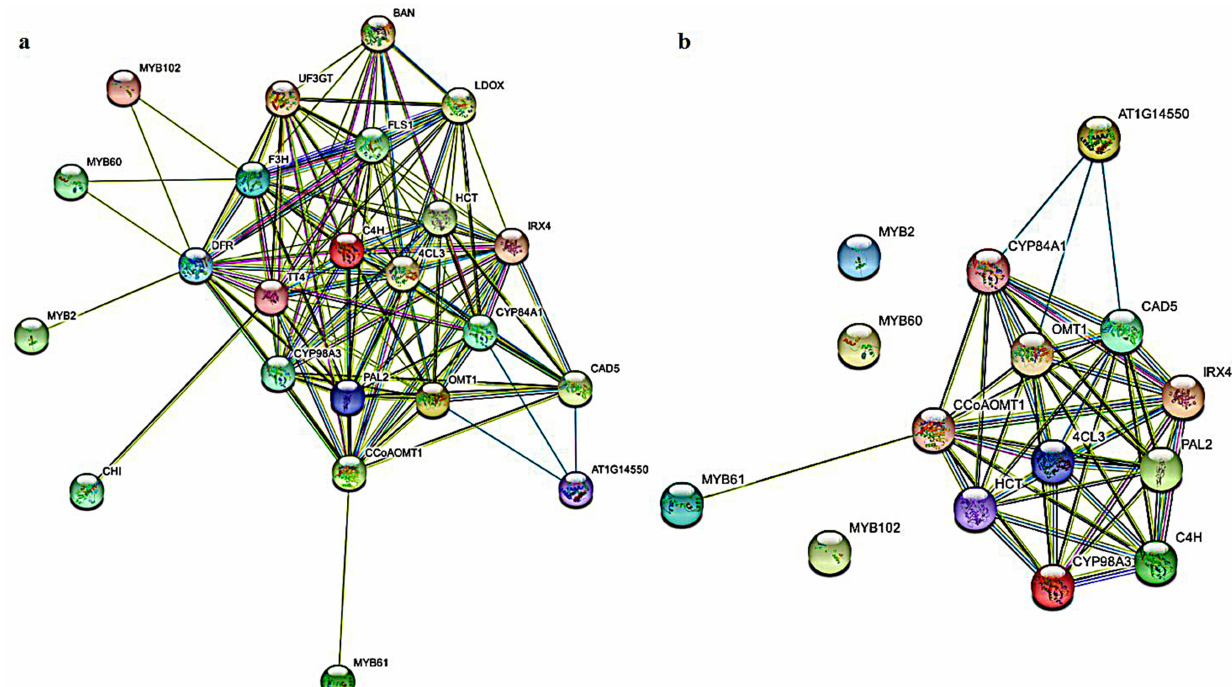
Figure 6. Protein regulatory network of AcMYBs protein in kiwifruit. ( a ) Protein regulatory networks of MYBs and structural genes of phenylpropanoid pathway. ( b ) Protein regulatory networks of MYBs and structural genes of lignin metabolic pathway. The purple line represents that interaction of the experimental results. Yellow-green, black and blue lines represent text mining, co-expression and protein homology, respectively.